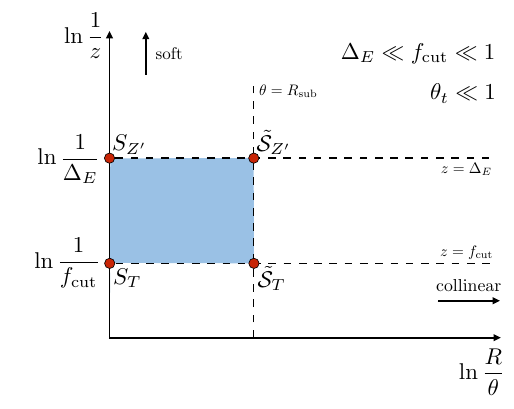
Figure 22 . Lund diagram for the energy drop of a trimmed jet. The relevant SCET modes are indicated by red